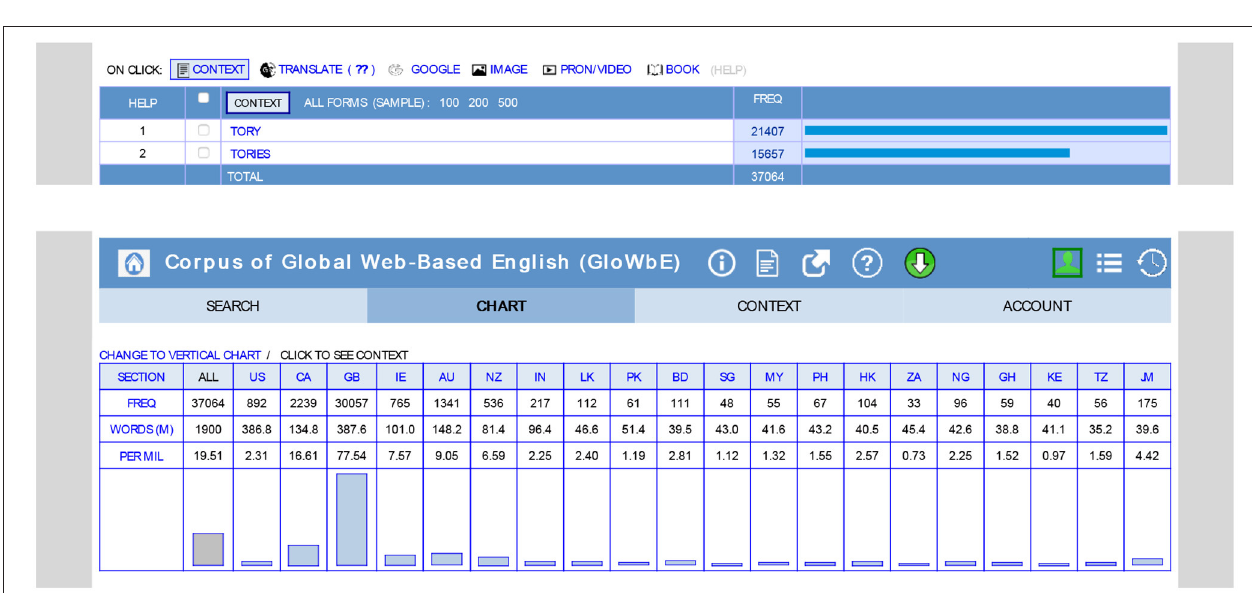
FIGURE 20 | Distribution of Tory/Tories in the GloWbE Corpus (from